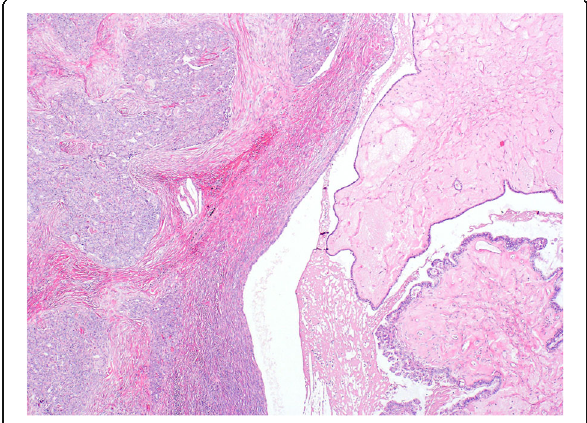
Fig. 1 Low power view showing serous borderline tumor (right) and mesonephric-like adenocarcinoma (left) (HE,